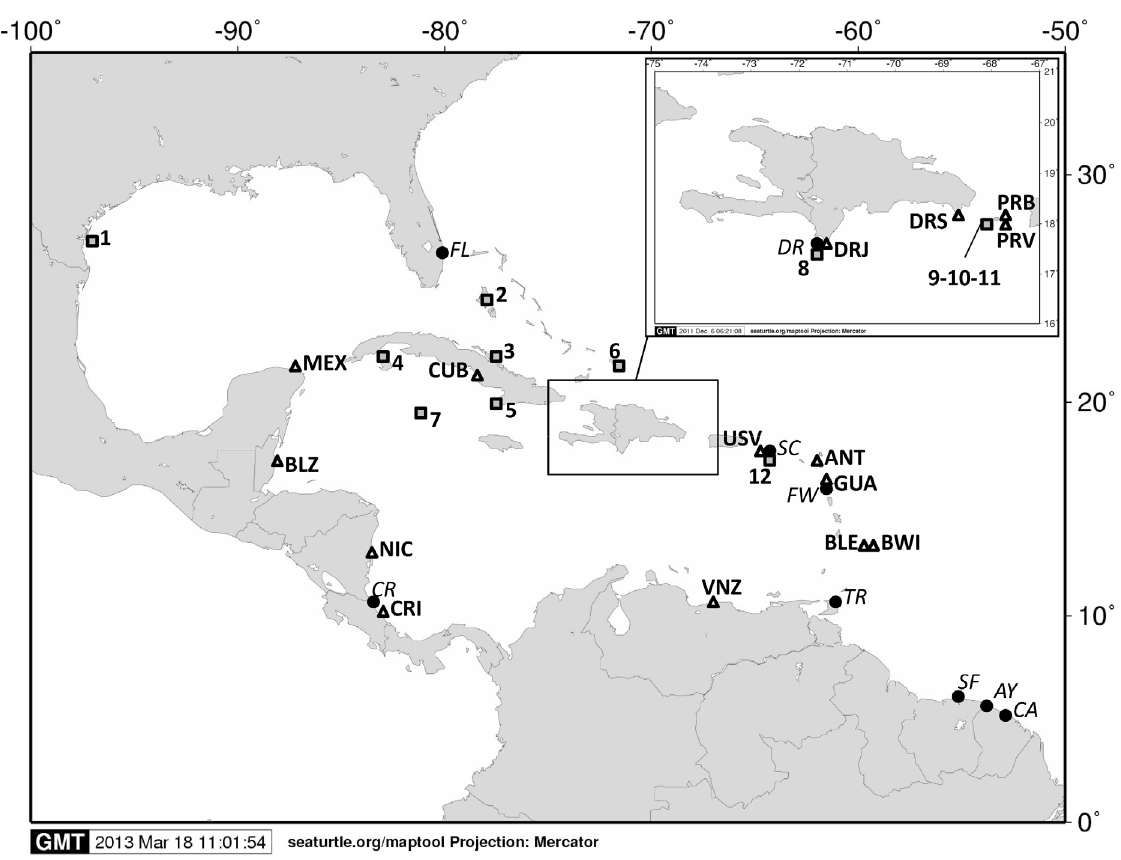
Figure 1. Marine turtle nesting sites and feeding grounds considered in this study. Leatherback nesting sites are represented by black circles labelled in italics. AY: Awala-Yalimapo; CA: Cayenne; CR Costa Rica (Atlantic); FL: Florida; FW: French West Indies; SC: Saint Croix; SF: Suriname/ FG; TR: Trinidad; DR: Dominican Republic. Hawksbill nesting sites are represented by white triangles labelled in bold. ANT: Antigua; BLE: Barbados Leeward; BWI: Barbados Windward; BLZ: Belize; CRI: Costa Rica; CUB: Cuba; GUA: Guadeloupe; MEX: Mexico; NIC: Nicaragua; PRV: Puerto Rico [35]; PRB: Puerto Rico [64]; USV: US Virgin Islands; VNZ: Venezuela; DRJ: Dominican Republic-Jaragua; DRS: Dominican Republic-Saona. The hawksbill population of BRZ: Brazil and the leatherback populations of BZ: Brazil and SA: South Africa are not included in the map. Hawksbill feeding grounds are represented by numbered grey squares. 1. Texas; 2. Bahamas; 3. Cuba D; 4. Cuba B; 5. Cuba A; 6. Turk and Caicos; 7. Caiman Islands; 8. Dominican Republic; 9. Puerto Rico residents; 10. Puerto Rico recruits; 11. Puerto Rico pooled; 12. US Virgin Islands. Sampling sites of the present study were the Jaragua National Park (DRJ or DR) and Saona Island (DRS). Map created using MAPTOOL [106].